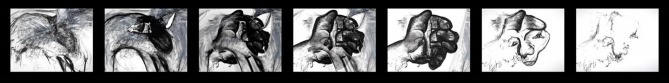
Exemplary frames of the stop-motion movie “Konstrukte” by Claudia Muth (from the year 2009). Image courtesy of Claudia Muth (see Supplementary Material for the two versions of the full movie).